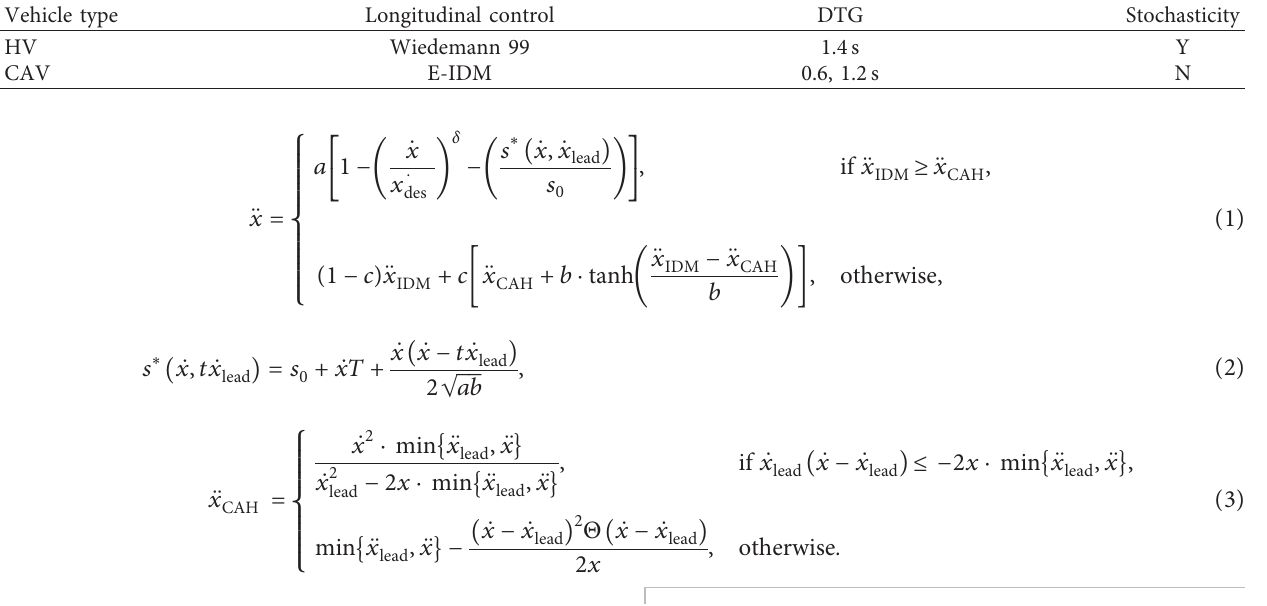
Table 2: Differences between HVs and CAVs in the simulation